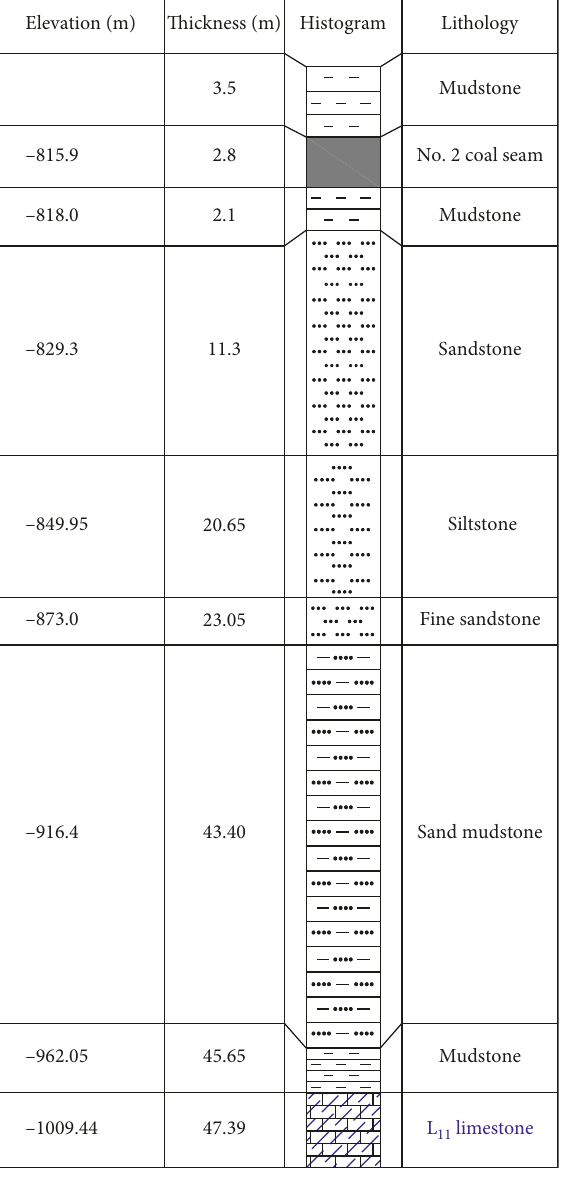
Figure 3: Coal seam